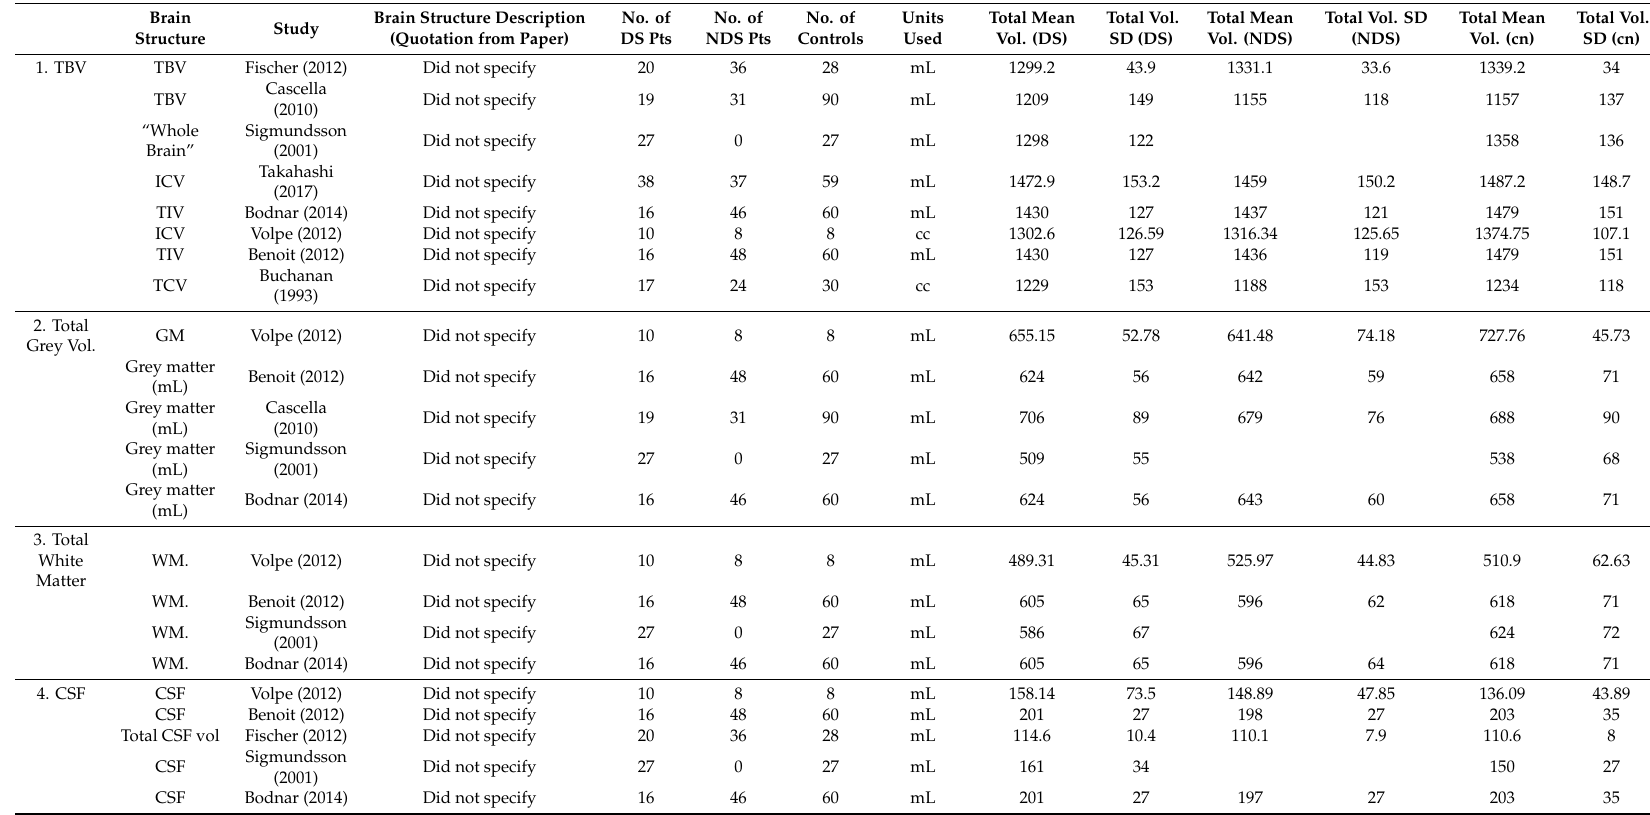
Table A3. Mean and SD values for ROIs with more than three